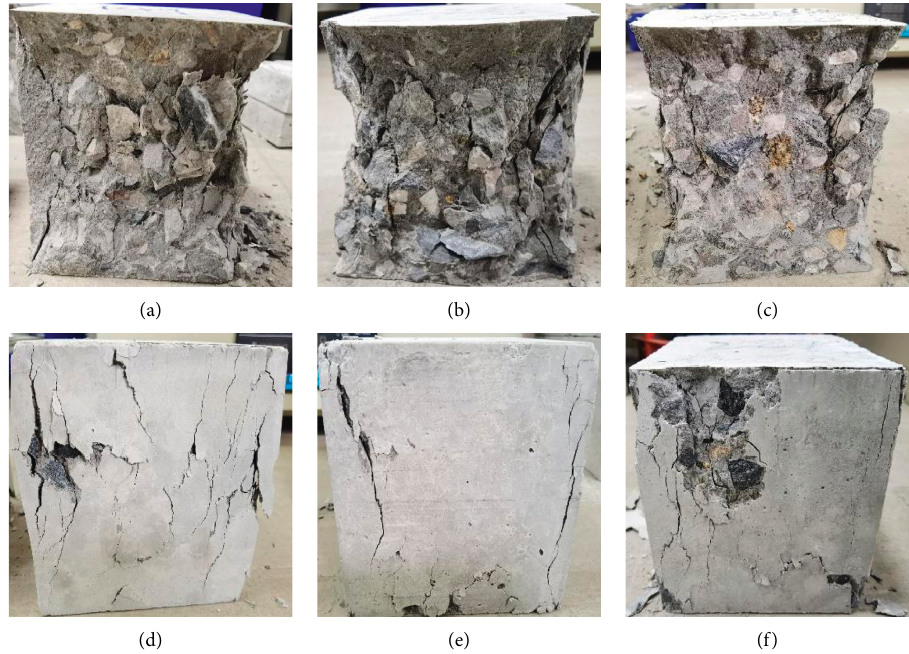
Figure 3: Failure mode of the coarse aggregate interlocking concrete subjected to different increasing amounts of coarse aggregates under compressive load. (a) PT-0. (b) PT-5. (c) PT-10. (d) PI5. (e) PT-20. (f) PT-25.